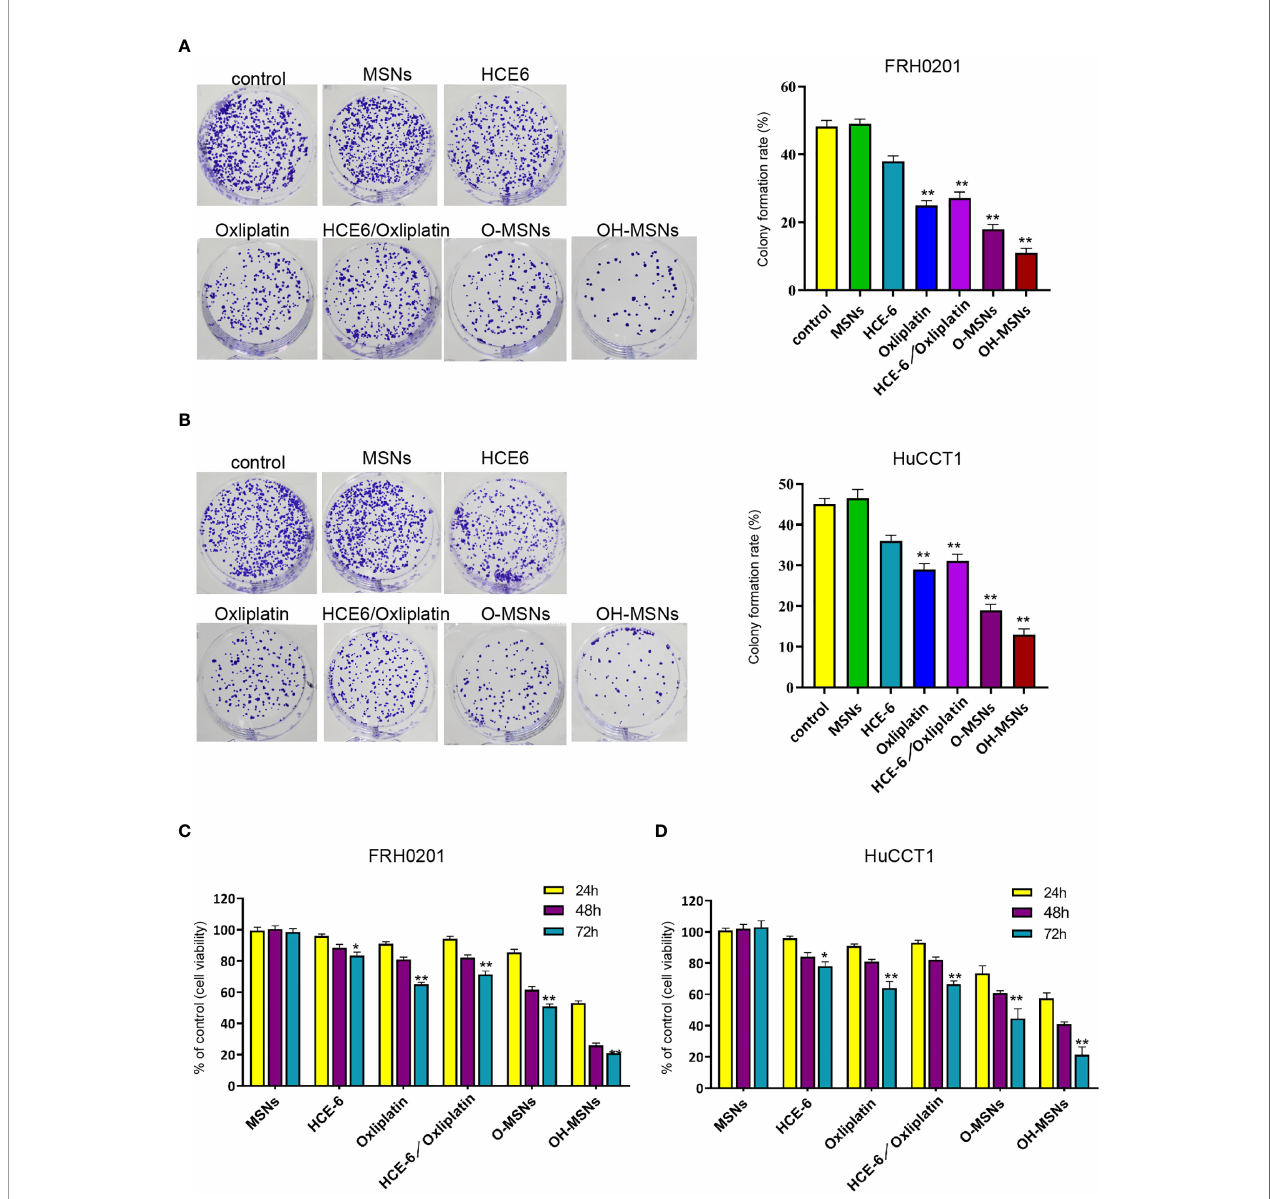
FIGURE 4 | Cell viability and proliferation ability of cholangiocarcinoma cells. (A – D) The FRH0201 and HuCCT1 cells were treated as the indicated labeling. (A, B) The cell proliferation was measured by colony formation assays. (C, D) The cell viability was analyzed by CCK-8 assays. Data are presented as mean ± SD. Statistic signi fi cant differences were indicated: *P < 0.05, **P <